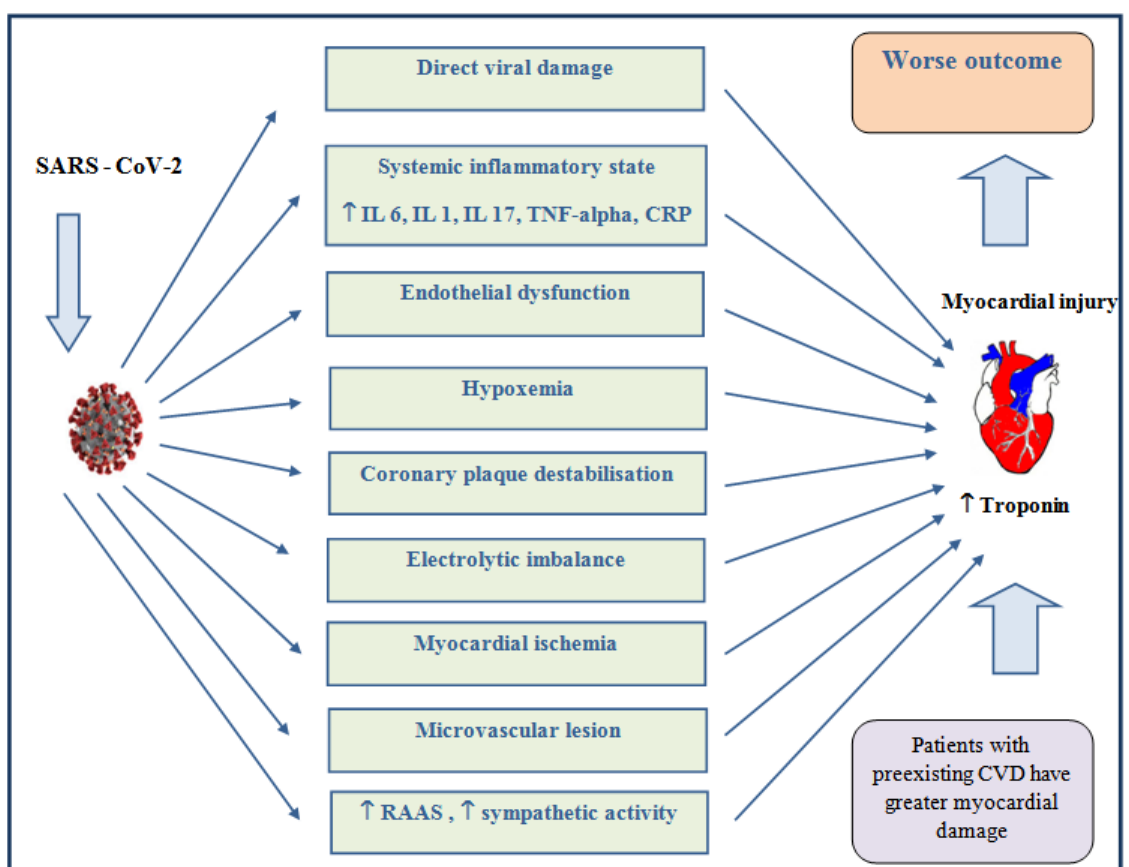
Figure 2. Possible mechanisms of myocardial injury in patients with COVID-19. Legend: IL 6—interleukin 6; IL 1—interleukin 1; IL 17—interleukin 17; TNF-alpha—tumor necrosis factor-alpha; CRP—C-reactive protein; RAAS—renin–angiotensin–aldosterone system; CVD—cardiovascular disease.